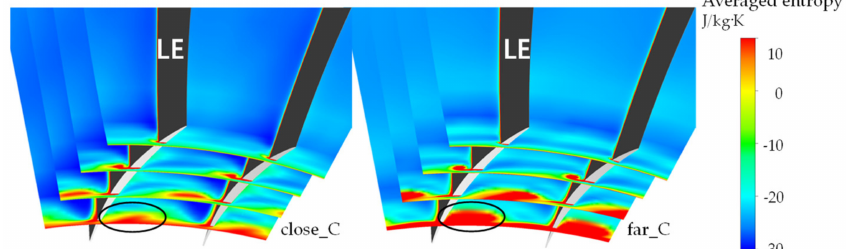
Figure 13. Time-averaged entropy contour near the hub.